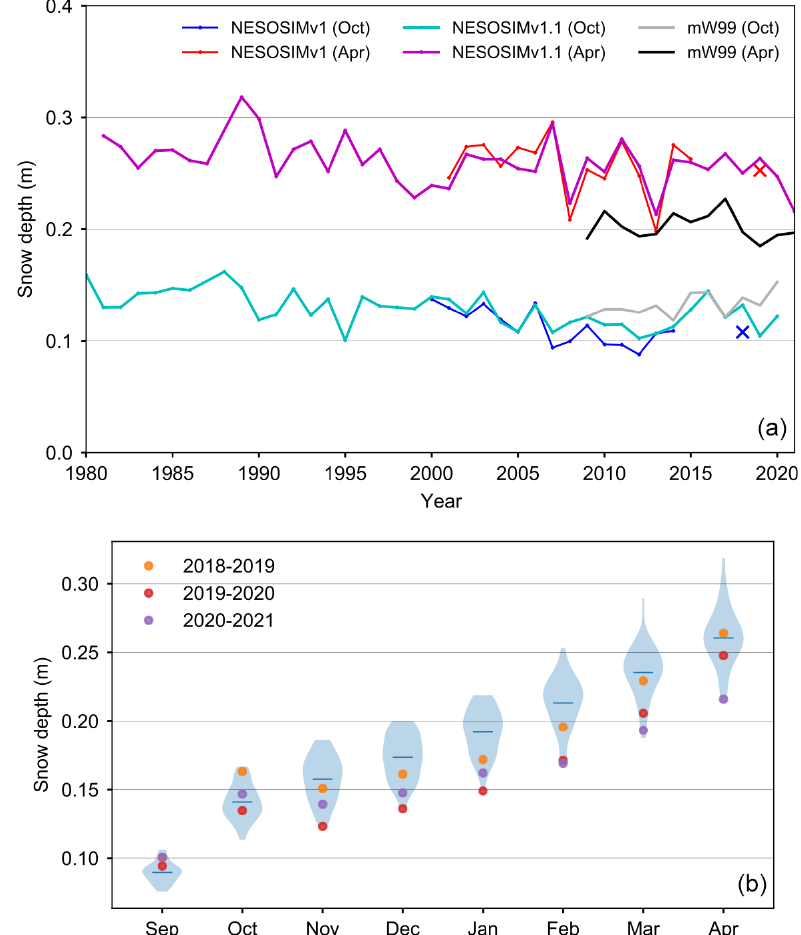
Figure 4. (a) Mean snow depths in October and April from NESOSIM v1.0 (blue and red, respectively) and v1.1 (cyan and magenta) within an Inner Arctic Ocean domain (Fig. 5). NESOSIM snow depths are also masked where concentration (from passive microwave) is less than 50%. The cross markers show the extended ICESat-2 NESOSIM v1.0 results used in (Petty et al., 2020). The black/grey lines show the modified Warren climatology (mW99) in October and April, respectively, for regions of coincident NESOSIM v1.1 coverage in that given year. (b) Violin plots showing interannual distributions of monthly mean snow depths from NESOSIM v1.1 within an Inner Arctic Ocean domain from 1980–2021; coloured markers indicate mean monthly snow depths for recent (ICESat-2)